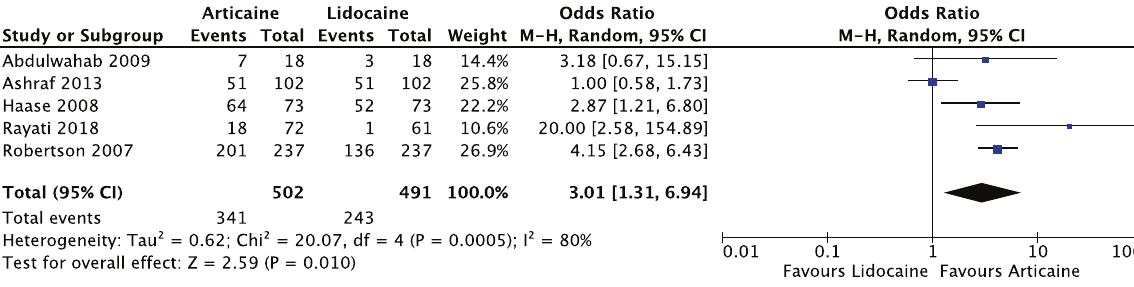
Fig. 7 Forest plot — mandibular in fi ltrations. Articaine had 3.01 times likelihood of anaesthetic success of lidocaine.